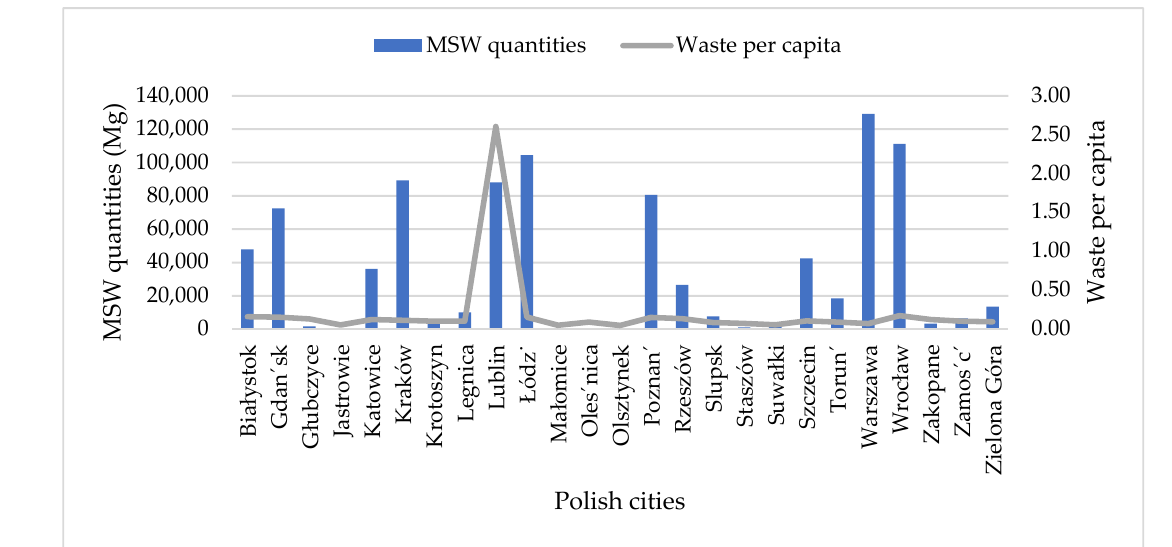
Figure 5. Distribution of municipal wastes in Polish cities. Table 2. Statistical parameters of input and output parameters for MSW